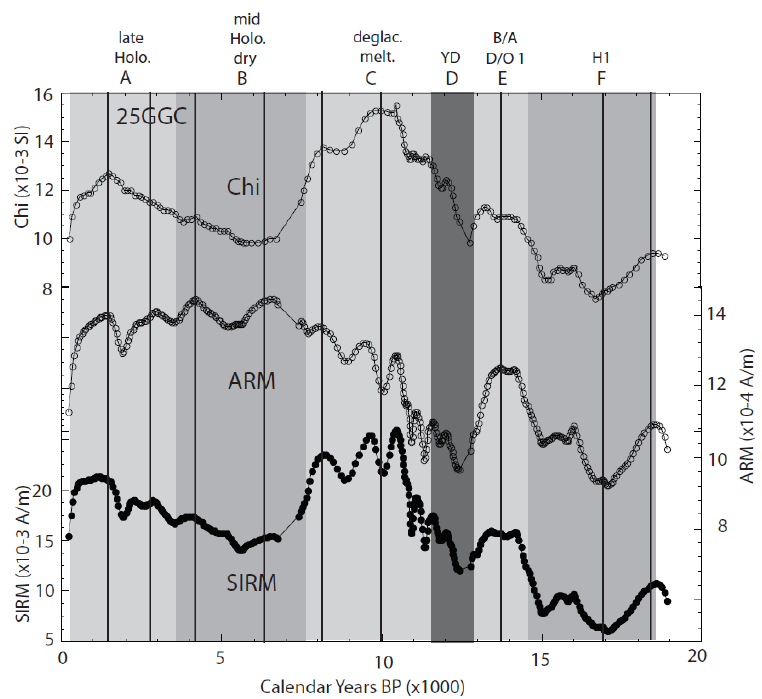
Figure 7. Rock magnetic intensity variability for core 25GGC versus time. Alternating light and dark grey zones are multi-millennial-scale oscillations in magnetic intensity (light = higher intensity; dark = lower intensity) labeled A–I. Vertical lines estimate finer-scale millennial intensity peaks that are superposed on the longer-term variability.